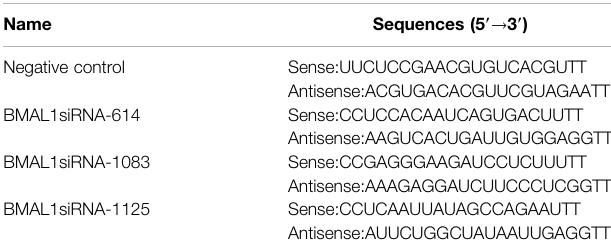
TABLE 1 | Three siBMAL1 sequences and negative control sequence for the